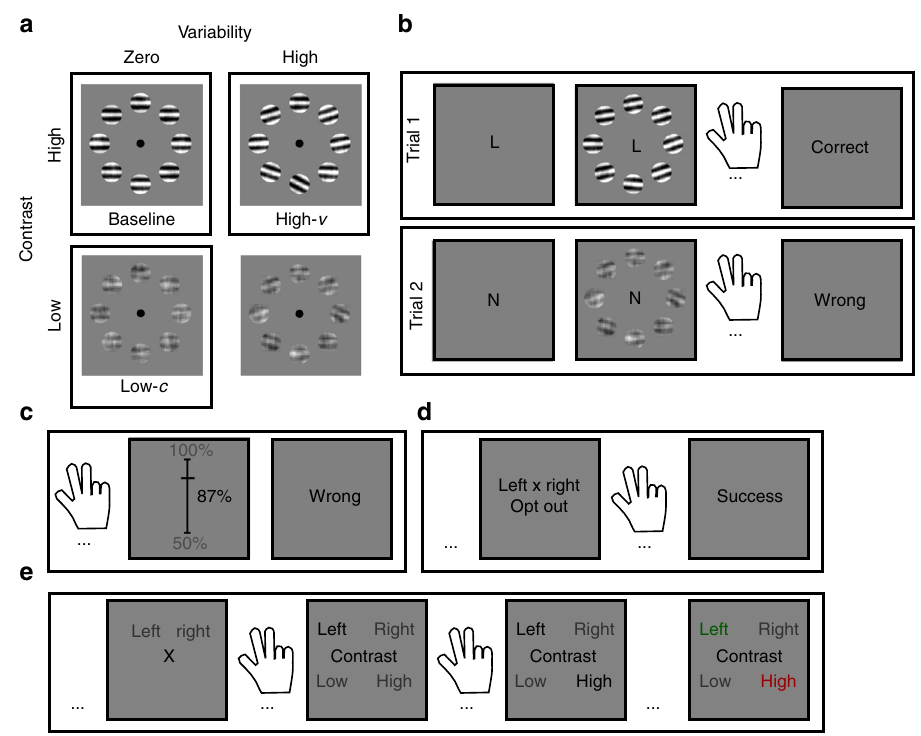
Fig. 1 Experimental paradigm. a We manipulated the stimulus contrast and the orientation variability of an array of eight gratings in a factorial manner. The boxes highlight the three critical conditions. b Participants categorized the average orientation of an array as clockwise (CW, “ left ” ) or counter-clockwise (CCW, “ right ” ) relative to horizontal. A cue indicated the prior probability of occurrence of each stimulus category ( “ L ” : 25% CW, 75% CCW; “ N ” : 50% CW, 50% CCW; “ R ” : 75% CW, 25% CCW). The cue was shown at the start of a trial and remained on the screen until a response had been registered. Participants received categorical feedback about choice accuracy, before continuing to the next trial. Feedback was based on the average orientation of the array shown on the screen. c In Experiment 2, after having made a choice, participants estimated the probability that the choice was correct by sliding a marker along a scale (50 – 100% in increments of 1%). d In Experiment 3, participants could opt out of making a choice and receive “ correct ” feedback with a 75% probability. e In Experiment 4, after having made a choice, participants were required to categorise (low versus high) either the contrast or the variability of the stimulus array. Here we show a contrast